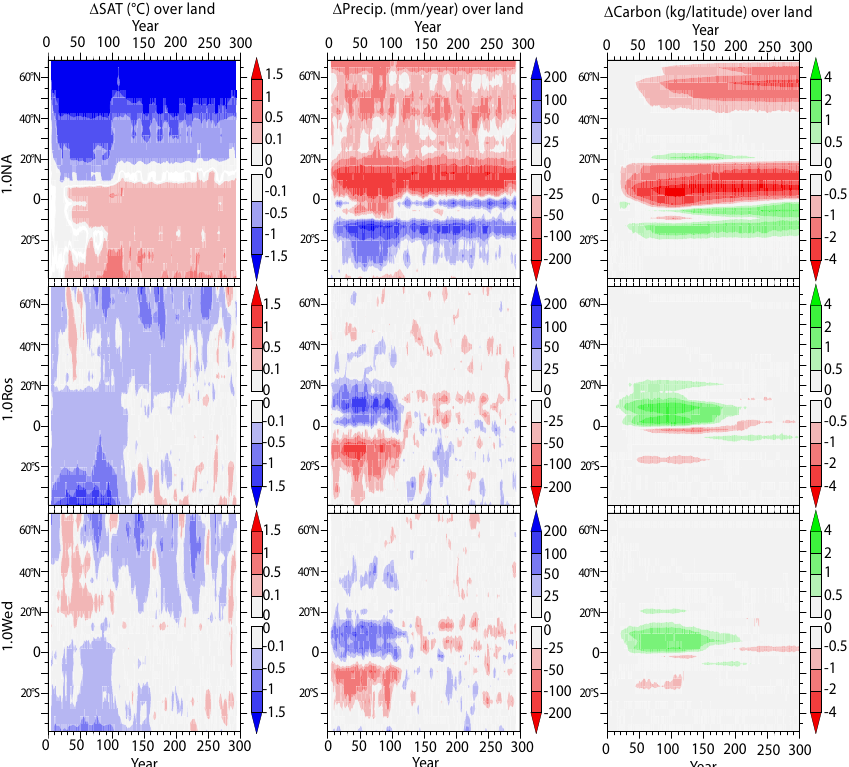
Fig. 4. From top to bottom, each row represents the experiments 1.0NA, 1.0Ros, and 1.0Wed, respectively. Given in each column are zonal mean changes of temperature (left), precipitation (middle) and total carbon per latitude (right) on land. The precipitation and the SAT values are averaged over 10